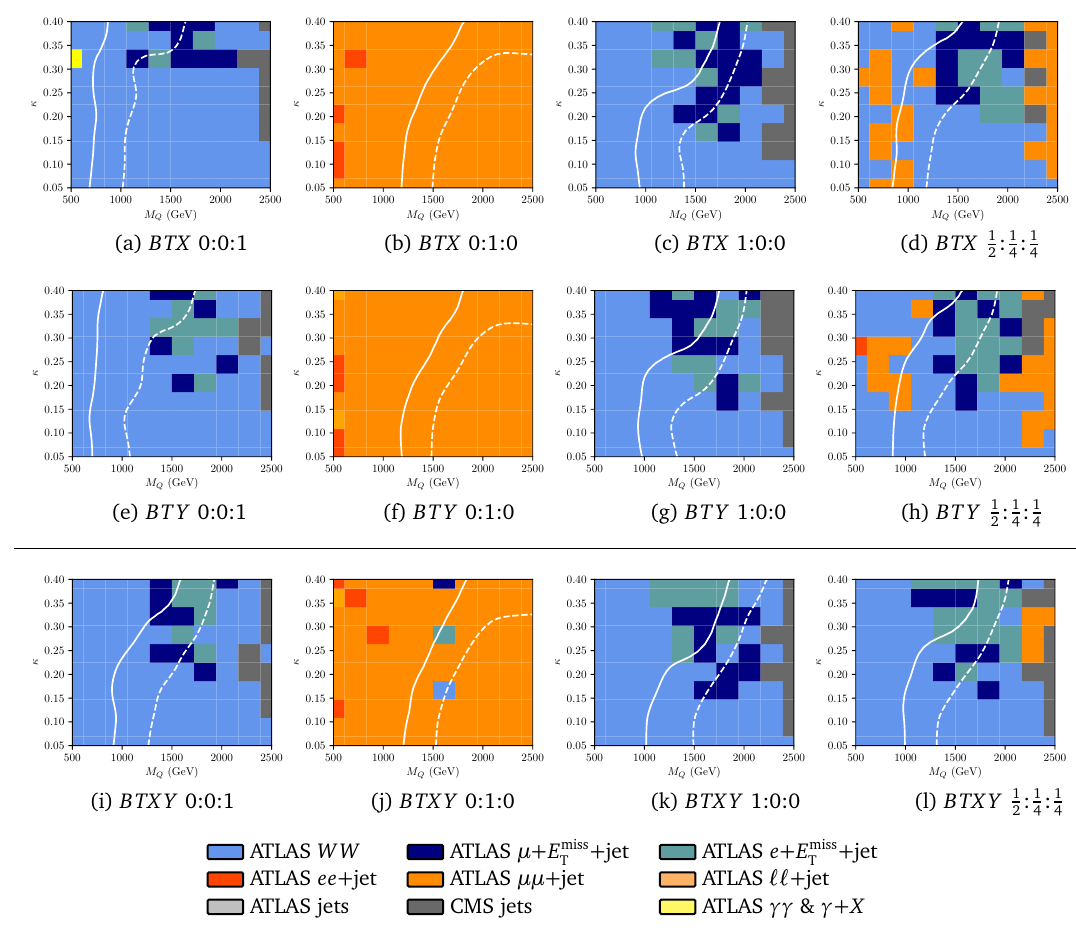
Figure 14: Sensitivity of LHC measurements to VLQ triplet production in the κ vs VLQ mass plane, where κ is the coupling to second-generation SM quarks. All VLQ masses are set to be degenerate. The multiplets are given as rows: (a)–(d)( B , T , X ) triplet, (e)–(h)( B , T , Y ) triplet, and for comparison to the main text, the (i)–(l)( B , T , X , Y ) quadruplet. The VLQ branching fractions to W : Z : H are arranged in columns of 0:0:1, 0:1:0, 1:0:0, and 1 : 1 : 1 from left to 2 4 4